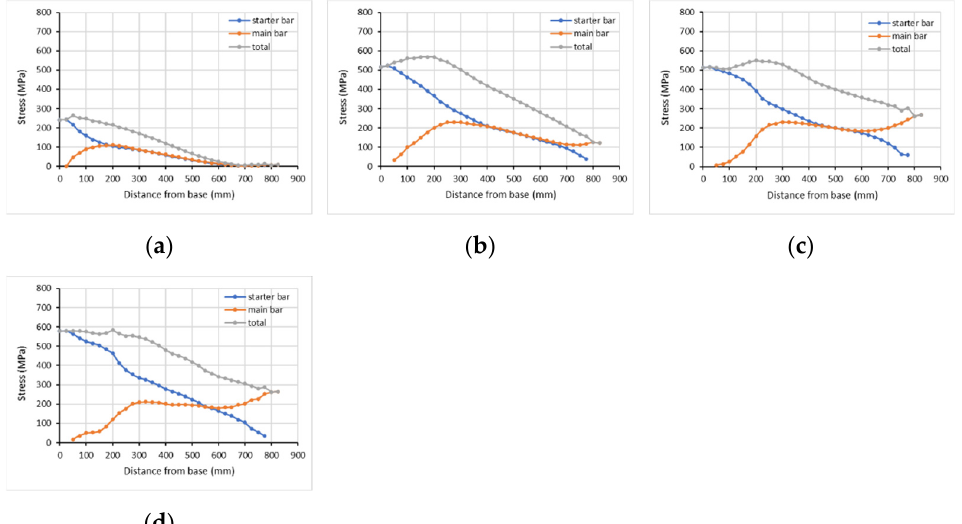
Figure 12. Developed stress along lap splice length at a displacement of ( a ) 3.15 mm, ( b ) 8.19 mm ( δ y ), ( c ) 22.34 mm ( δ Pmax ), and ( d ) 31.36 mm ( δ u ), for column R-0L4.